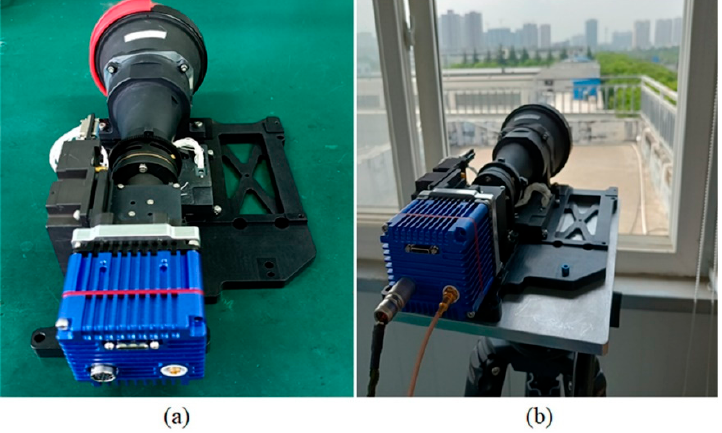
8 of 16 Figure 5. Framework of pipeline architecture on FPGA .